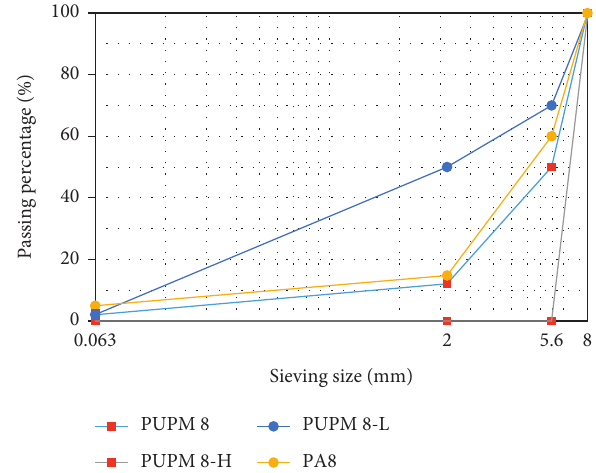
Figure 1: Grain size distribution of PUPM 8-H, PUPM 8, PUPM 8- L and PA